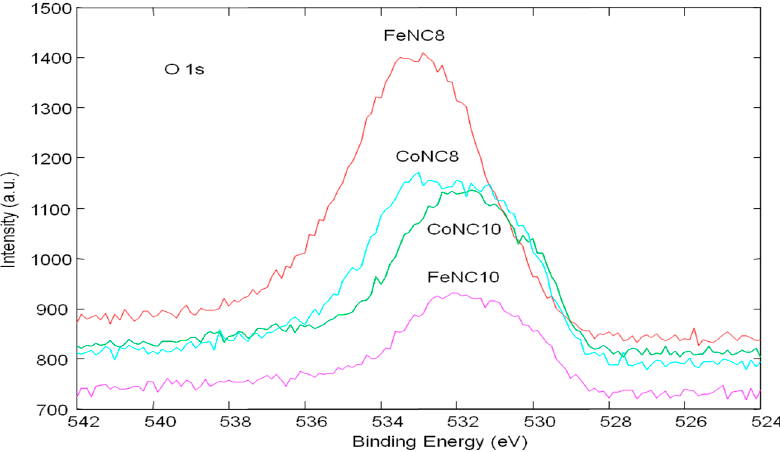
Figure 8. O 1s high resolution XPS spectra for CoNC8, CoNC10, FeNC8, and FeNC10 catalysts.